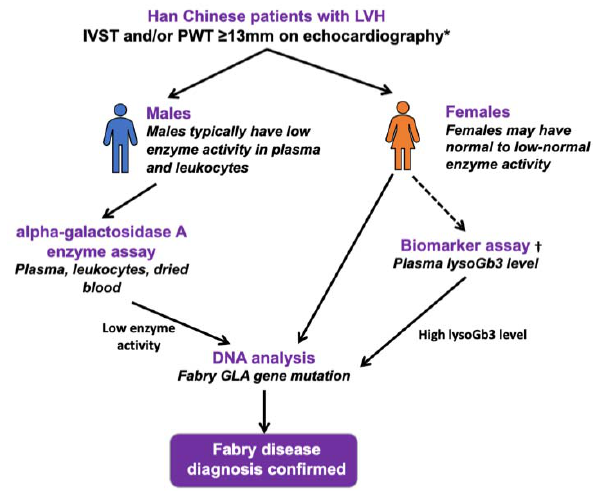
Figure 4. Proposed diagnostic flow chart for screening FD in men and in women with LVH. IVST = interventricular septal thickness; PWT = posterior wall thickness. * Potential red flags that should raise the clinical suspicion and prompt screening of FD in LVH patients include: Teochew people, heart failure, and arrhythmias; the presence of hypertension and/or aortic/mitral valve pathology should not exclude patients from FD screening. †Plasma lysoGb3 is a potential primary screening biomarker for FD in females.